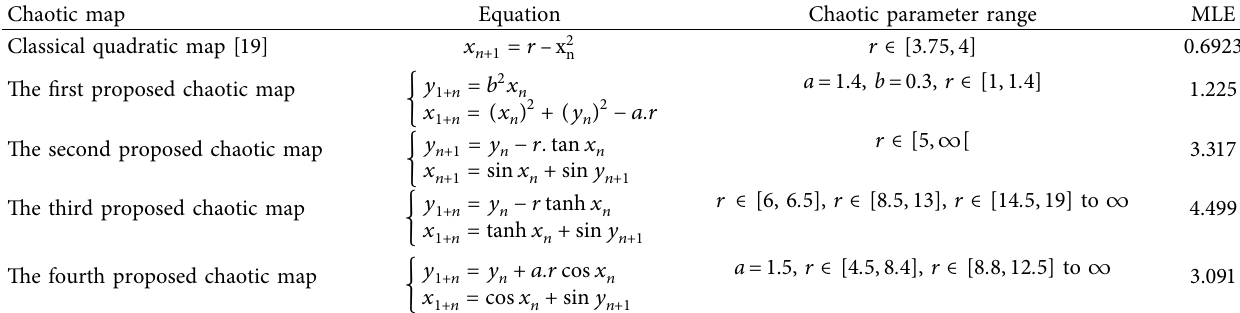
Table 1: Comparison between the classical and proposed quadratic maps. Note: MLE is Maximal Lyapunov Exponent.